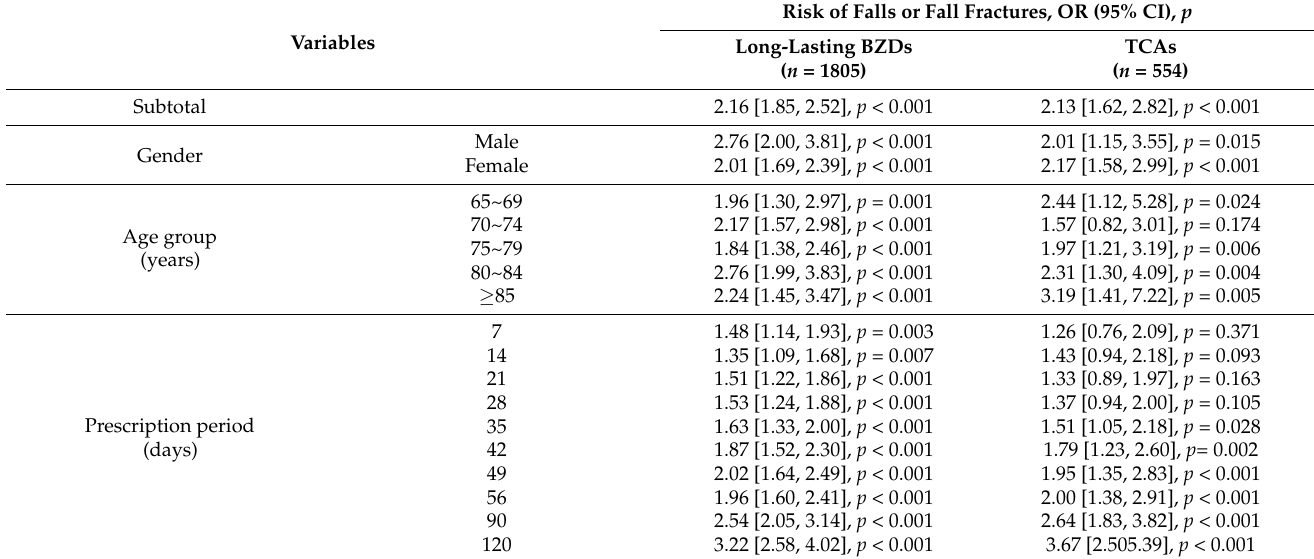
Table 2. Risk of Falls or Fall Fractures and Long-lasting BZDs or TCAs by Gender, Age, and Stage ( n = 2359).